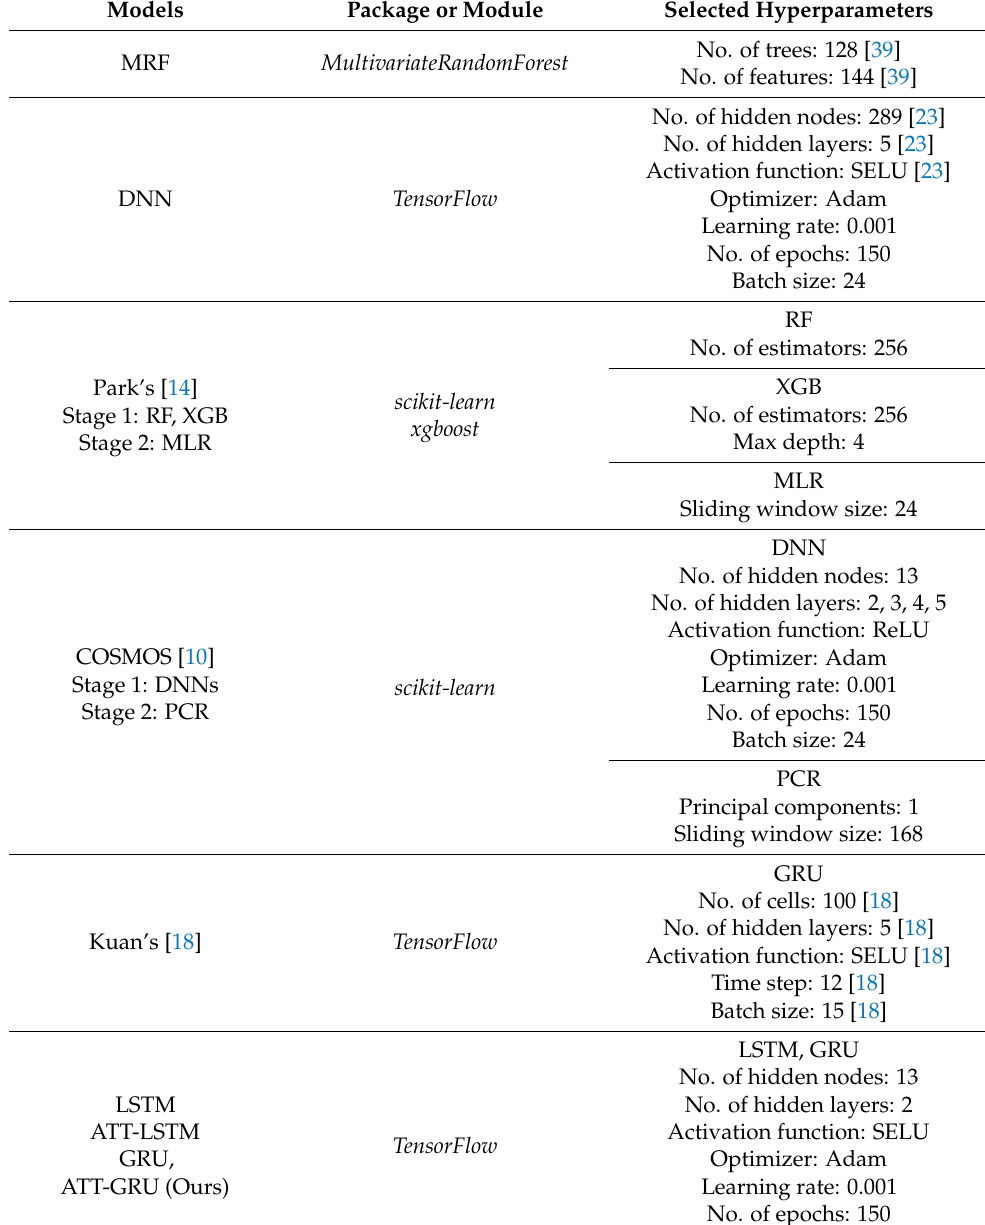
Table 6. Selected hyperparameters for each